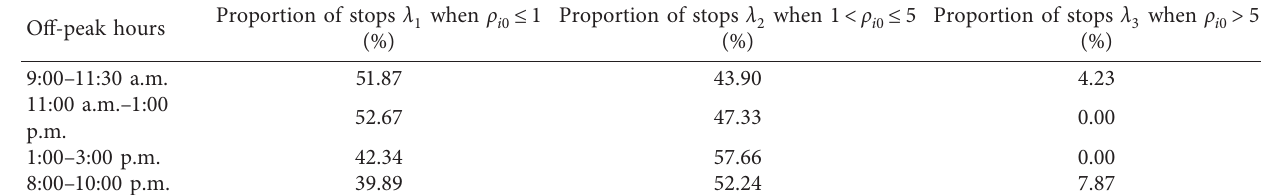
Table 3: Proportion of interstops classified during off-peak hours.